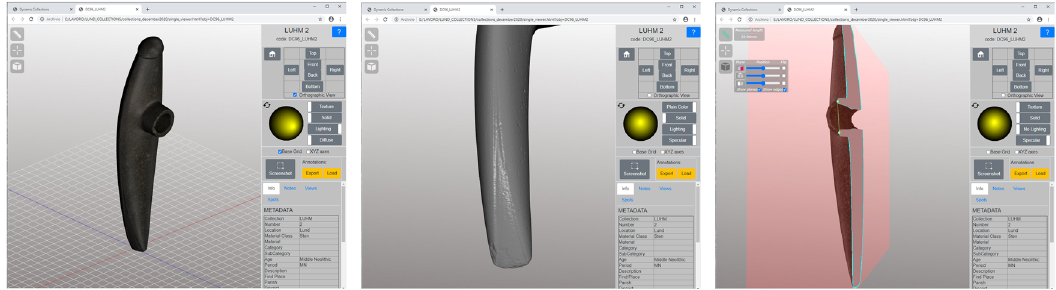
Figure 3: The 3D viewer o ff ers several tools and rendering modes to e ff ectively explore the